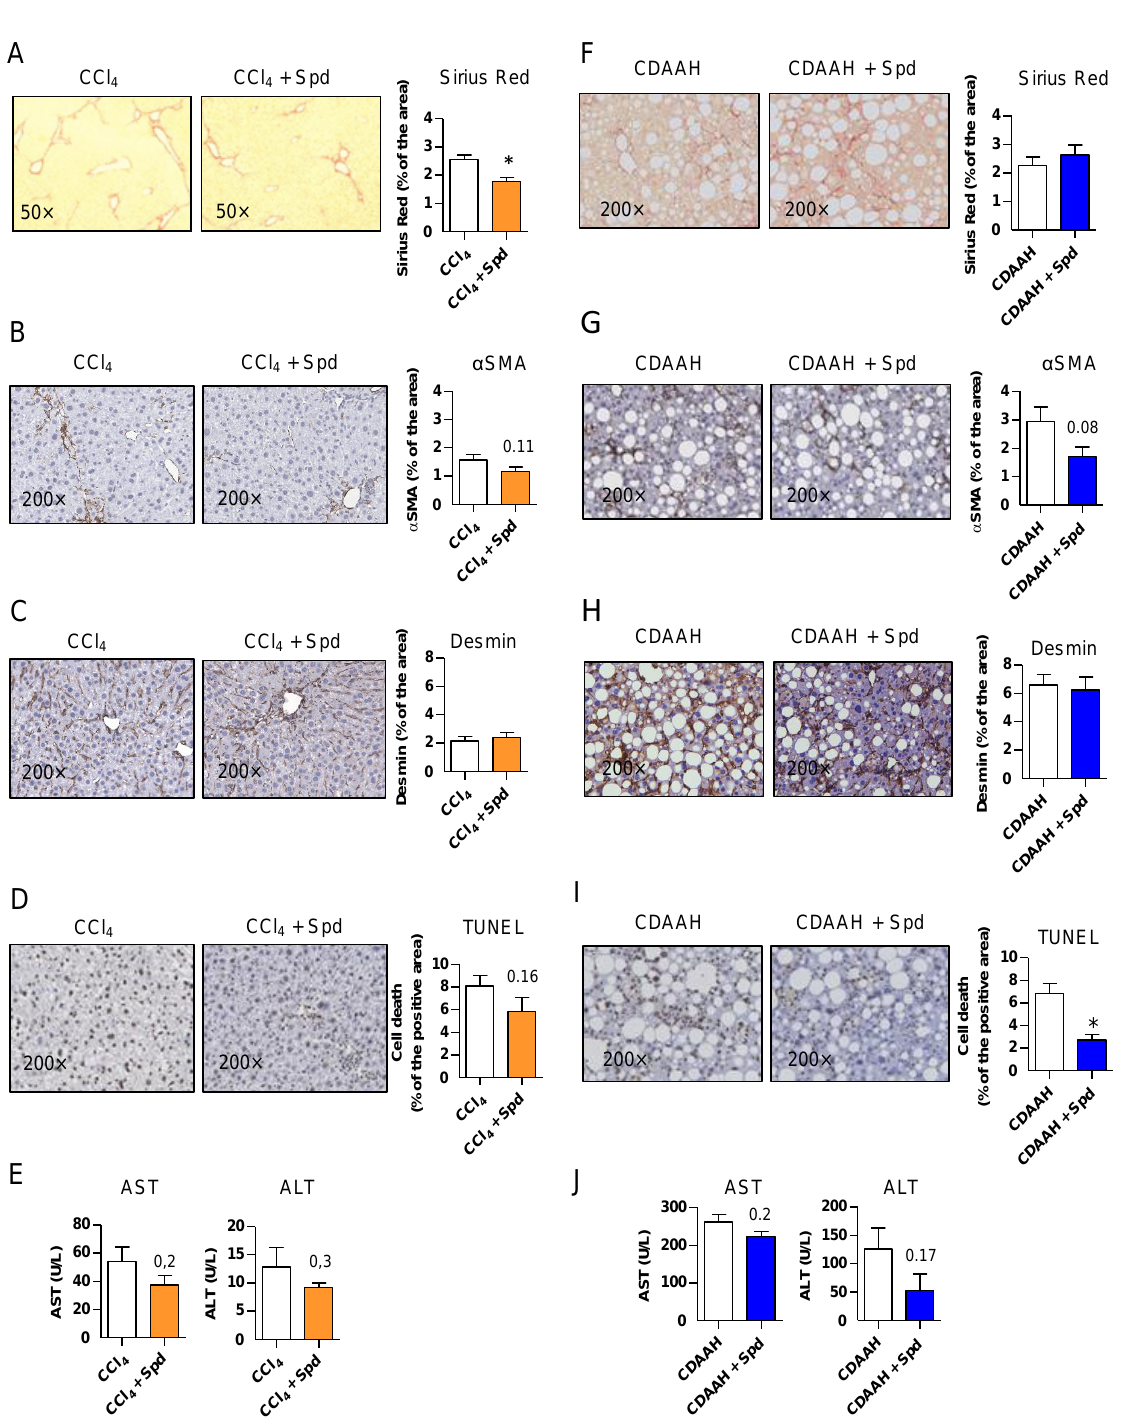
Figure 2. SPD improves the liver response to injury and attenuates fibrosis and HSC activation in vivo. ( A , F ) Sirius Red staining and quantification in whole liver tissue sections from the CCl 4 and CDAAH mice, respectively. ( B , G ) Immunohistochemistry and quantification of α SMA in whole liver tissue sections from the CCl 4 and CDAAH mice, respectively. ( C , H ) Desmin immunohistochemistry and quantification in whole liver tissue sections from the CCl 4 and CDAAH mice, respectively. ( D , I ) TUNEL assay performed on liver tissue sections from the CCl 4 or CDAAH mice, respectively. ( E,J ) Serum ALT and AST transaminases from the mice treated with the CCl 4 and CDAAH diet with or without SPD supplementation. For each study, n = 7–12 mice per group. The results are the means ± SEM; * p < 0.05 compared to the vehicle (Student’s t